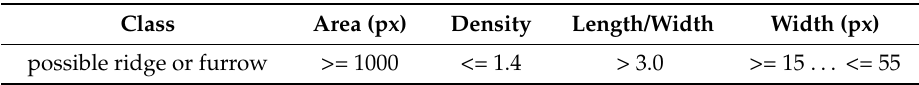
Table 6. Description of the final class ridge or furrow .